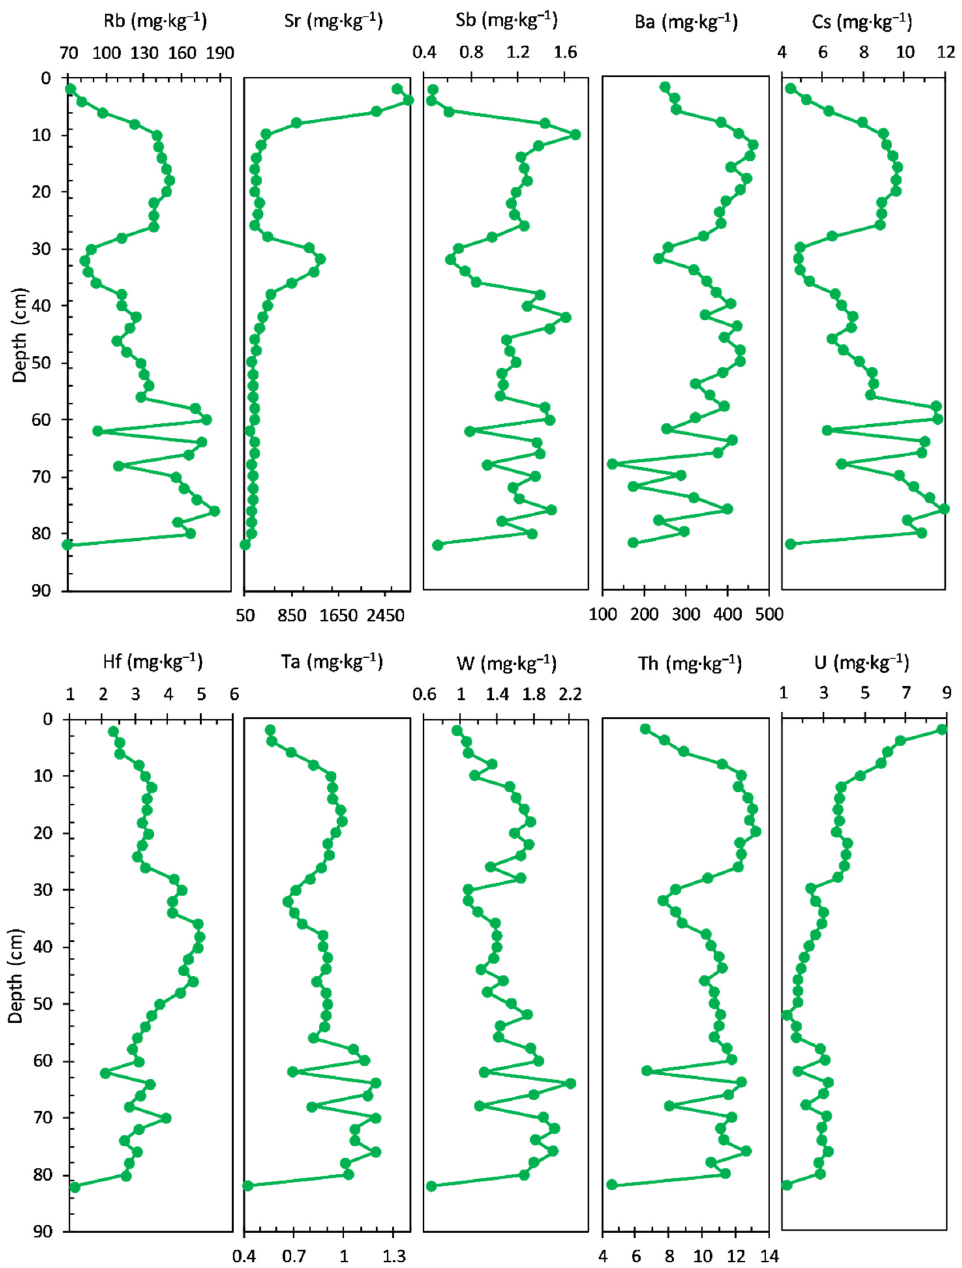
Figure 9. Vertical distribution of geochemical trace elements (Rb, Sr, Sb, Ba, Cs, Hf, Ta, W, Th, U) in the Caineni Lake sediment core (82 cm depth).